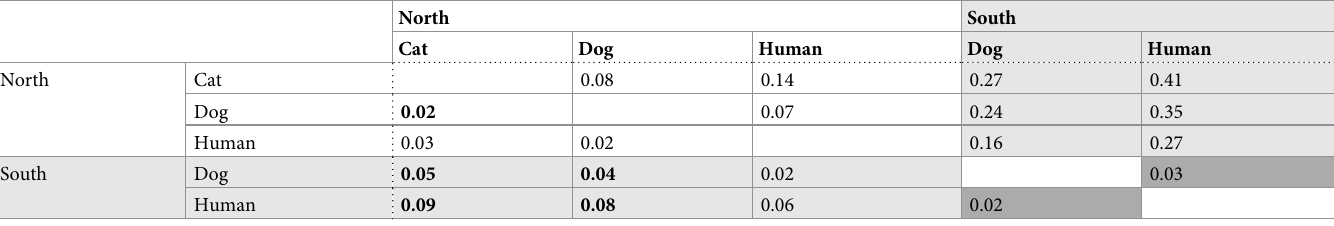
Human 0.09 0.02 Bold values indicate statistical significance at p < 0 . 05 . Below diagonal, pairwise F ST of derived maternal microsatellite genotypes; above diagonal, pairwise standardized F 0 ST of derived maternal microsatellite genotypes (statistical significance is not assessed for this measure).